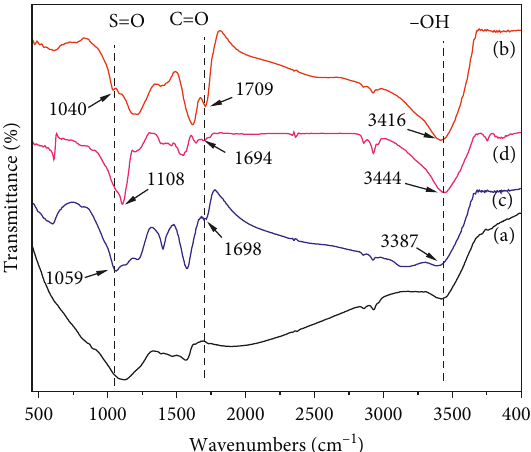
Figure 3: FT-IR spectra of activated carbon (a), sulfonated bio- char (b), graphene oxide (c), and GO/AC (d).